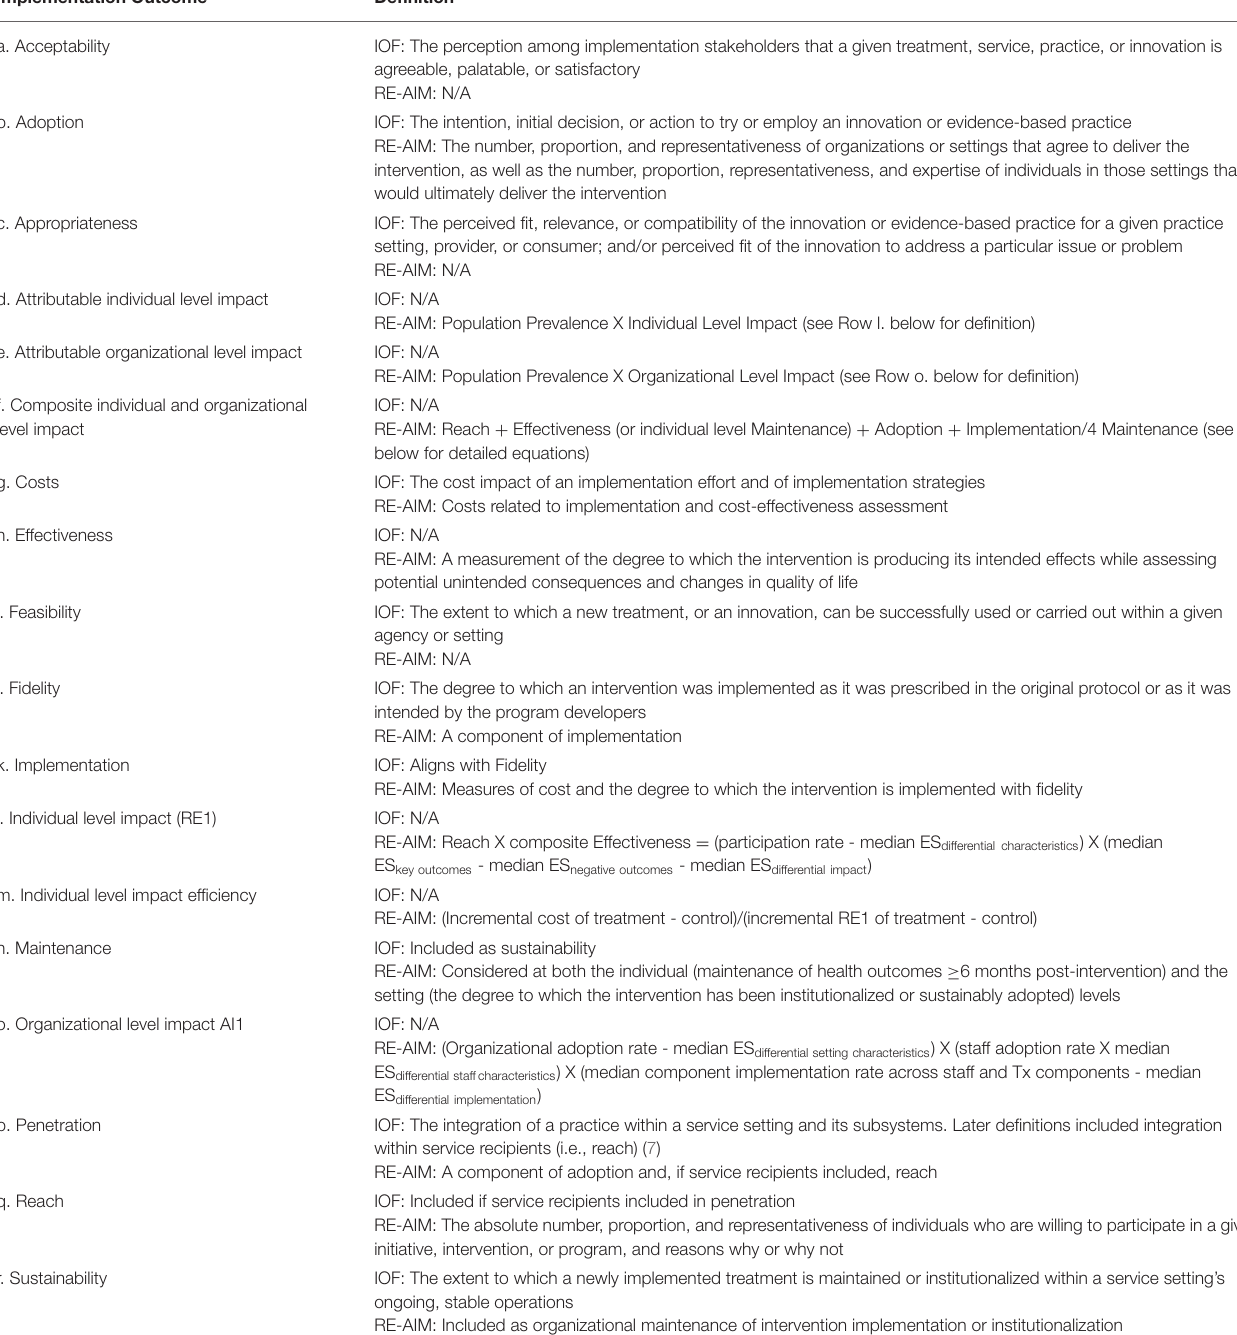
TABLE 1 | Definitions of IOF and RE-AIM